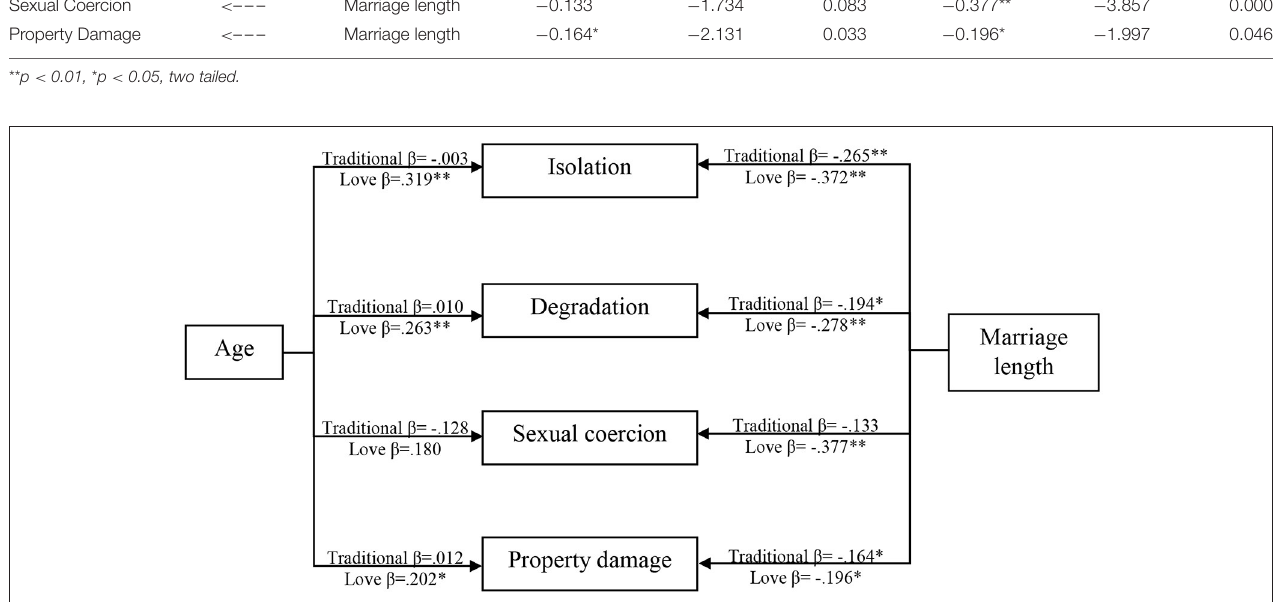
FIGURE 2 | Multi-group modeling between traditional and love